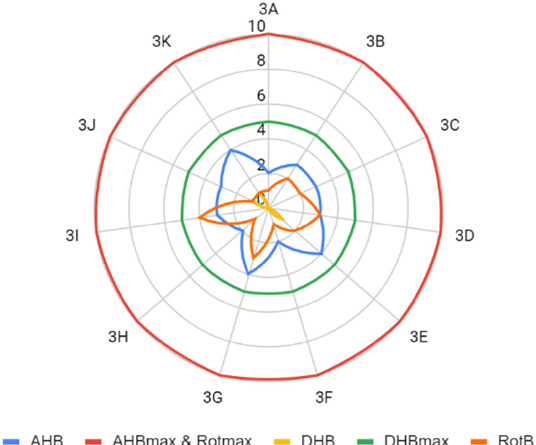
Figure 7. Comparison of the number of bonds (AHB—number of hydrogen bond acceptor, AHBmax—maximum number of hydrogen bond acceptor that satisfies Lipi ń ski’s rule, Rotmax—maximum number of rotating bonds that satisfies Veber’s rule, DHB—number of hydrogen bond donors, DHBmax—maximum number of hydrogen bond donors that satisfies Veber’s rule, RotB—number of rotating bonds).